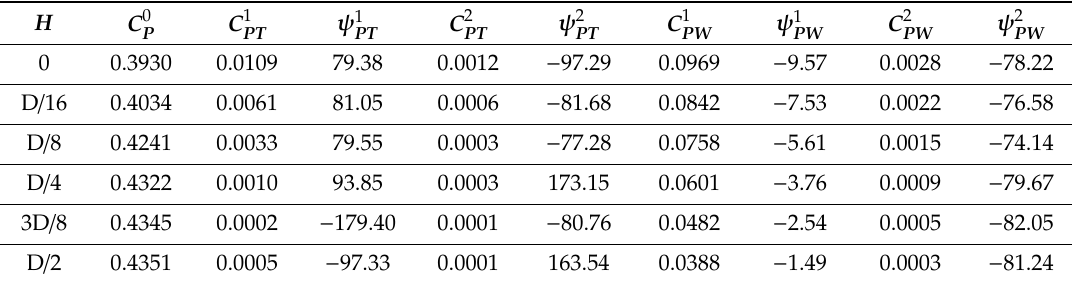
Expansion coe ffi cient table of energy utilization ratio under the di ff erent blade tip immersion